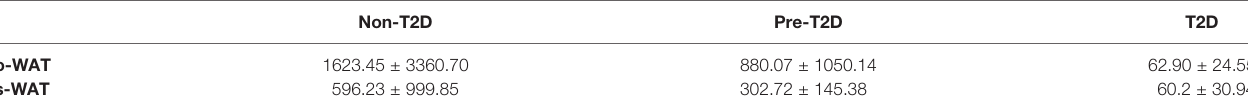
TABLE 2 | Number of mast cell progenitors per gram of white adipose